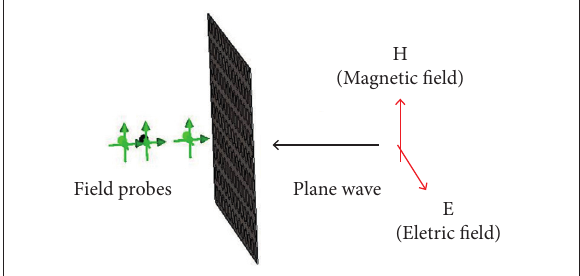
Figure 4. Finite FSS simulated with a plane wave